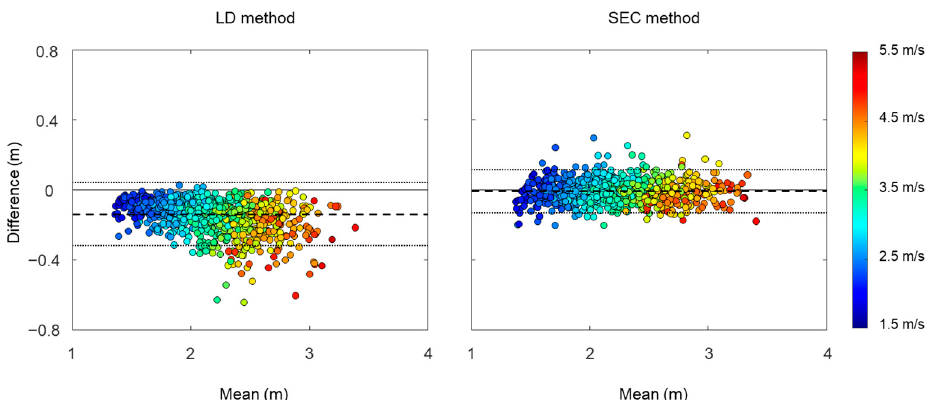
Figure 8. Bland–Altman plot with mean and difference in stride lengths estimated by linear dedrifting (LD) and spatial error correcting (SEC) methods and reference. Limits of agreement are shown as average difference (dashed line) ± 1.96 standard deviation of the difference (dotted line).